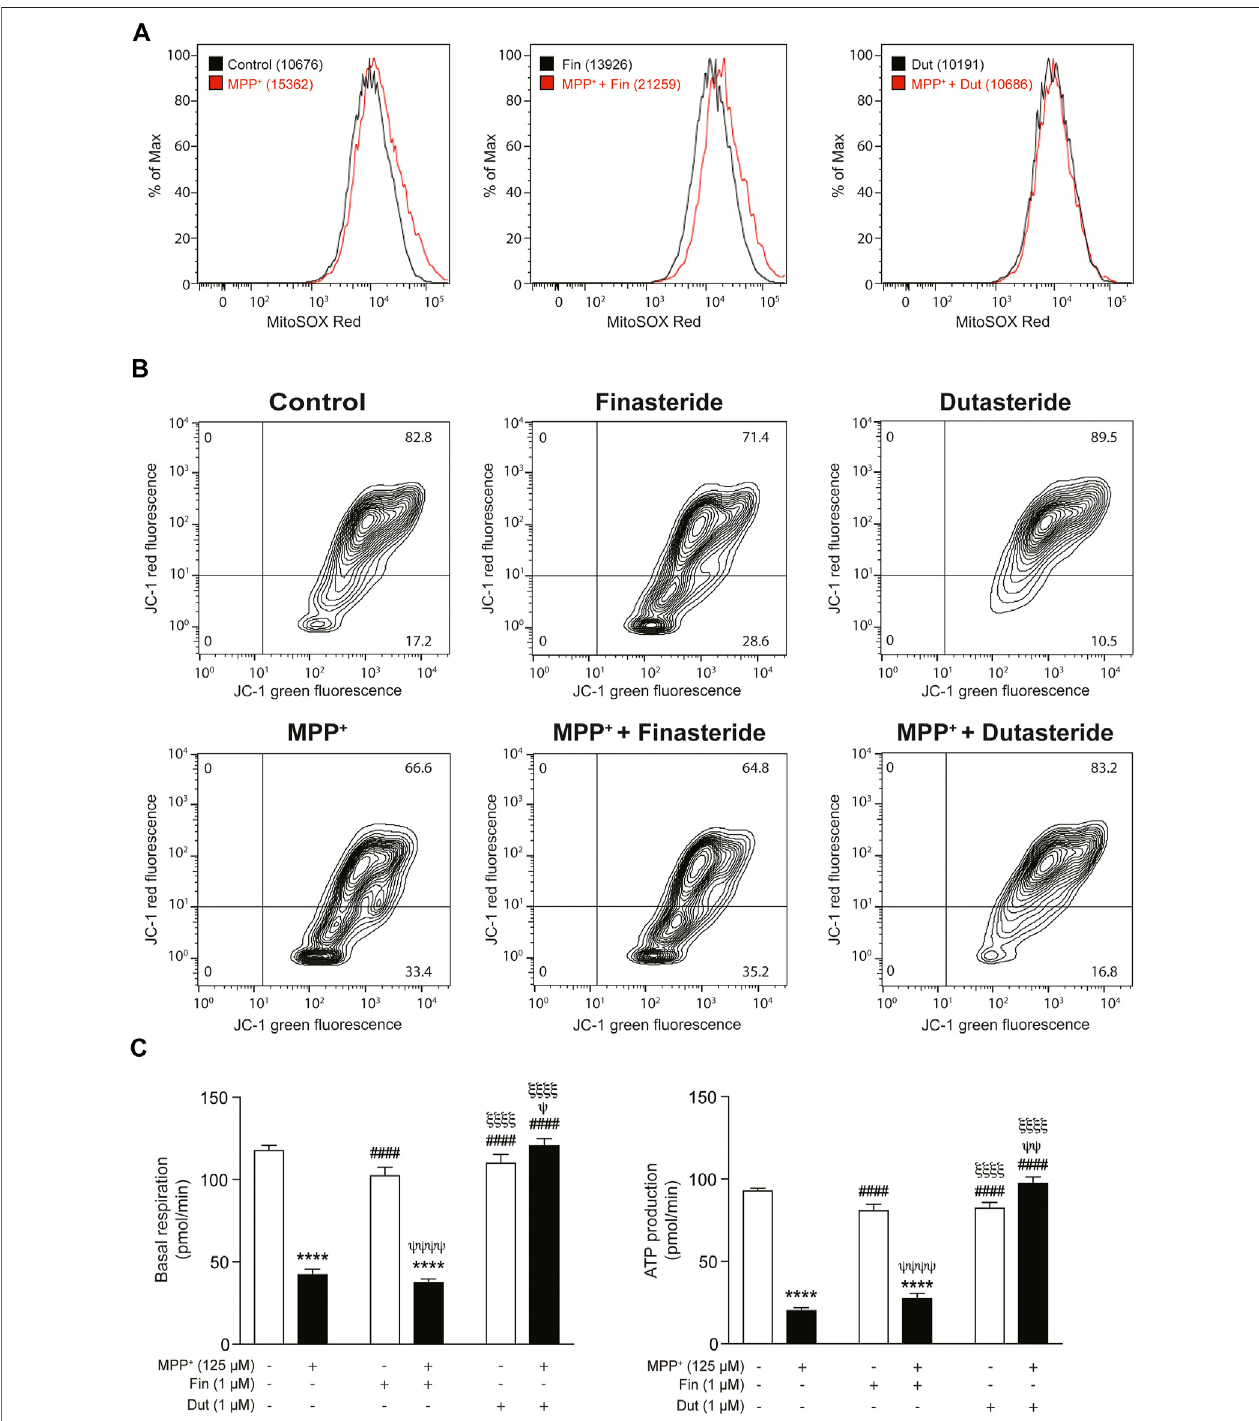
FIGURE 7 | Impaired mitochondrial function was prevented by dutasteride but not by fi nasteride treatment in MPP + -stimulated THP-1 cells. Three parameters of mitochondrial function were evaluated with fi nasteride- (Fin) or dutasteride-treated (Dut) THP-1 cells exposed or not to the MPP + toxin. Flow cytometry analyses were used to measure mitochondrial oxidative stress and membrane potential, while oxygen consumption rate (OCR) was quanti fi ed by Seahorse assays. (A) An increase in the mean fl uorescence intensity (MFI; values in parentheses) of the marker MitoSOX red reagent corresponds to an increase in mitochondrial oxidative stress production (shift of the curve to the right). (B) The JC-1 dye enables evaluation of the mitochondrial membrane potential; JC-1 green intensity increases with membrane depolarization, while JC-1 red intensity increases with polarized membranes. (C) Histograms show mitochondrial basal respiration and ATP production quanti fi cation in each condition (pmol/min). Results are the mean of three experiments. **** p < 0.0001 compared to control; #### p < 0.0001 compared to MPP + treatment; ψ p < 0.05, ψψ p < 0.01 and ψψψψ p < 0.0001 compared to fi nasteride only; ξξξξ p < 0.0001 compared to MPP + + fi nasteride.